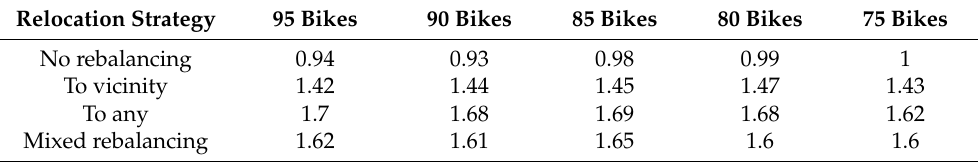
Table 4. Average energy consumption per bike for the different rebalancing strategies with different fleet sizes (in kWh).